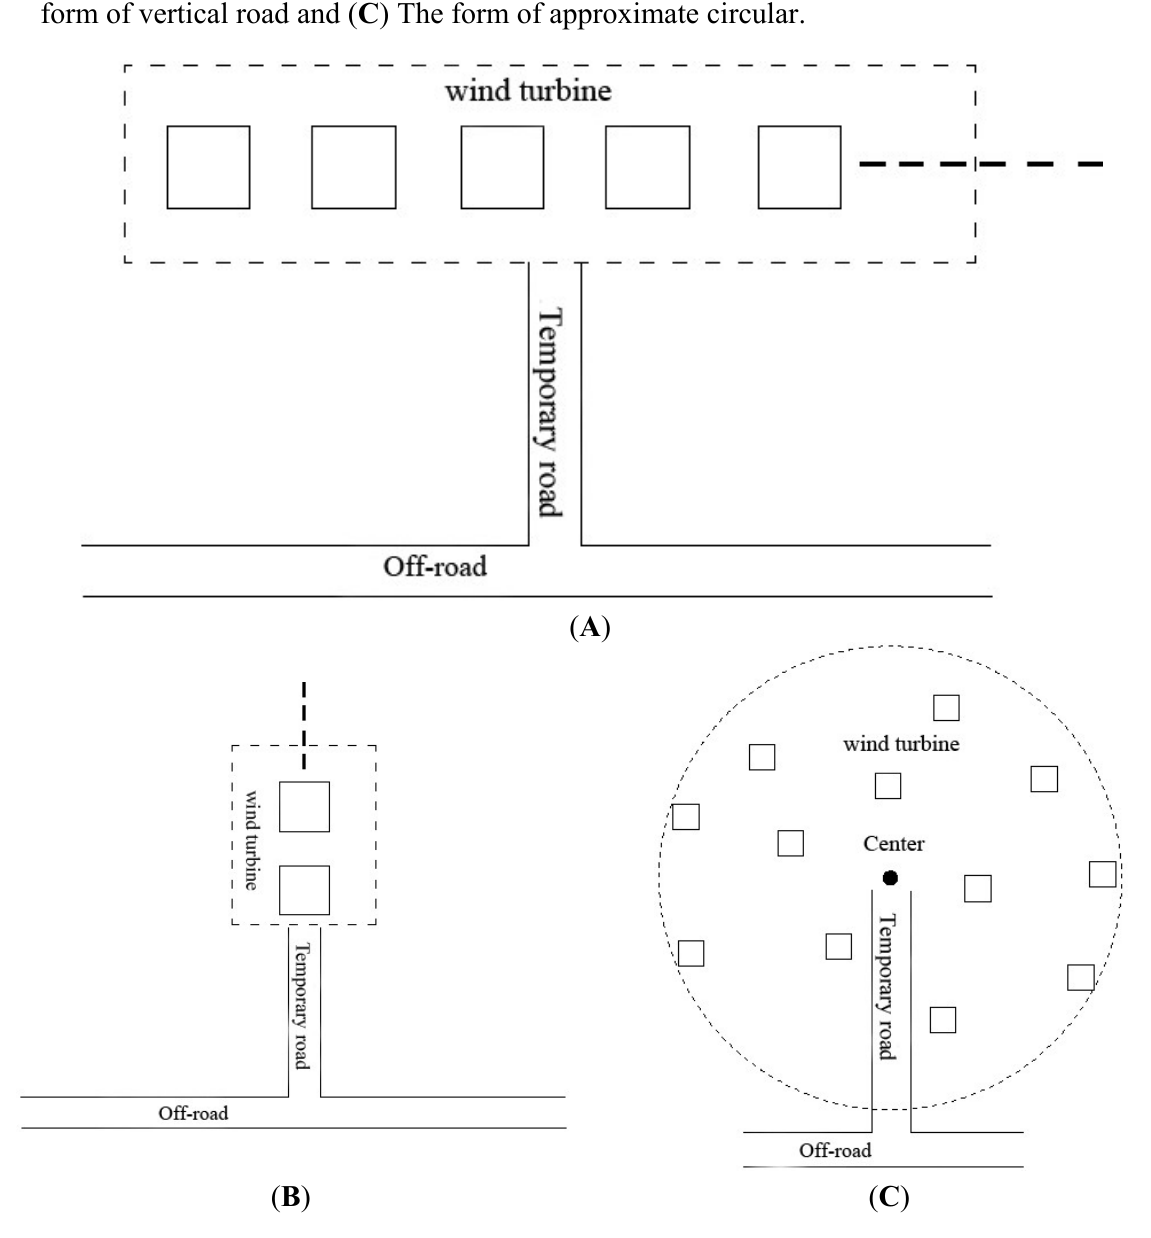
Figure 3. Optimal placement of the wind turbines lines ( A ) Parallel with the road, ( B ) The form of vertical road and ( C ) The form of approximate